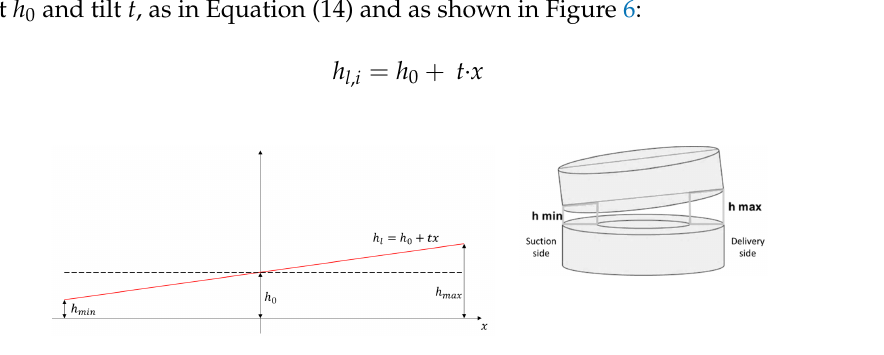
Figure 6. Inclination of the floating bushes.